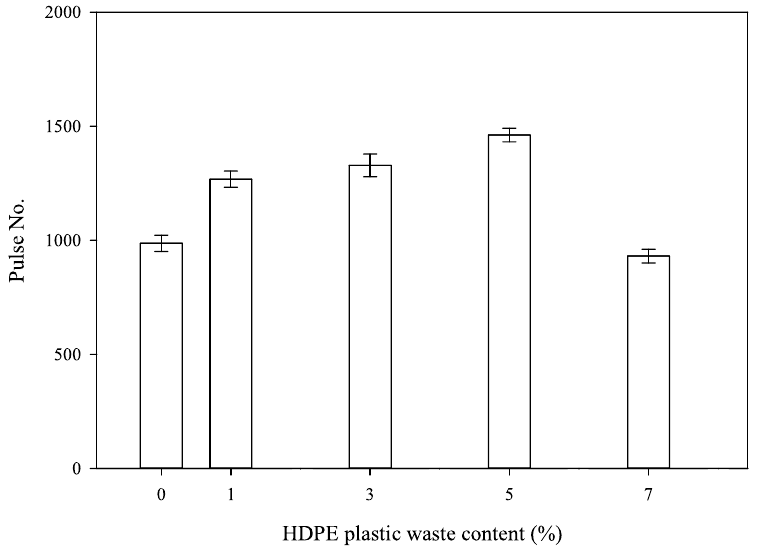
Figure 5. The fatigue life of